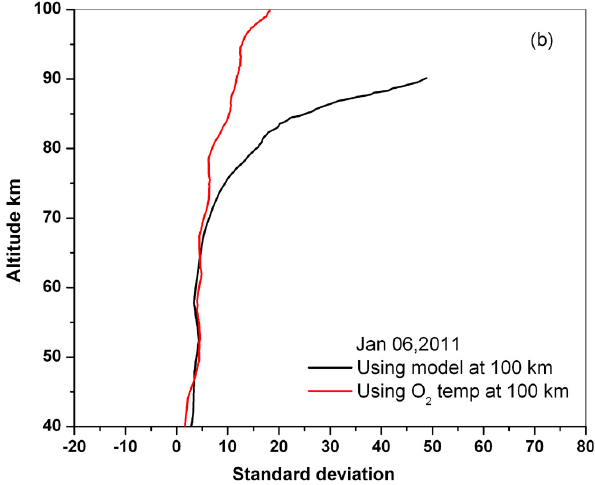
Fig. 2a. Same as Fig. 1a but for 27 January 2011.